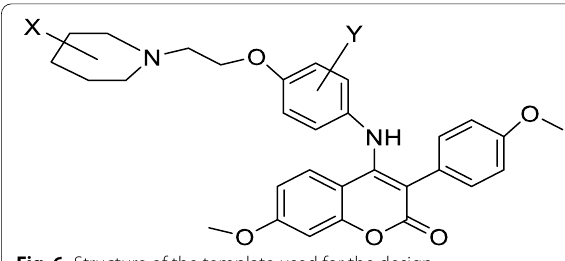
Fig. 6 Structure of the template used for the